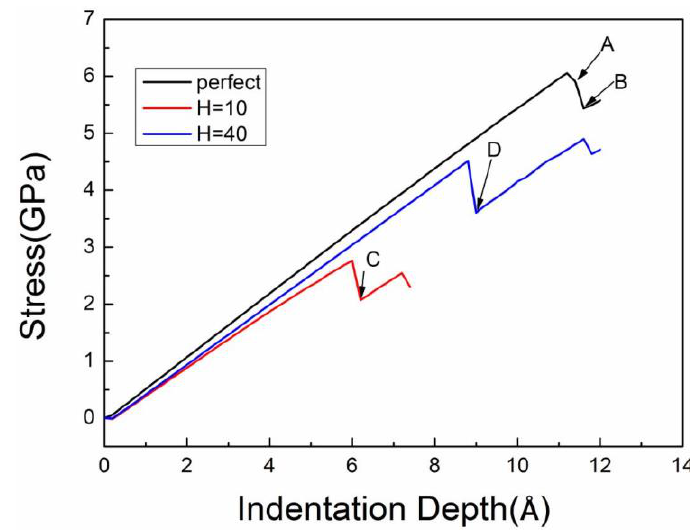
Figure 2. Three stress–displacement curves during nanoindentation of a perfect single crystal Al and two other Al matrixes containing a single circular cavity of D = 40 Å at the cavity depths of H = 10 Å and 40 Å .